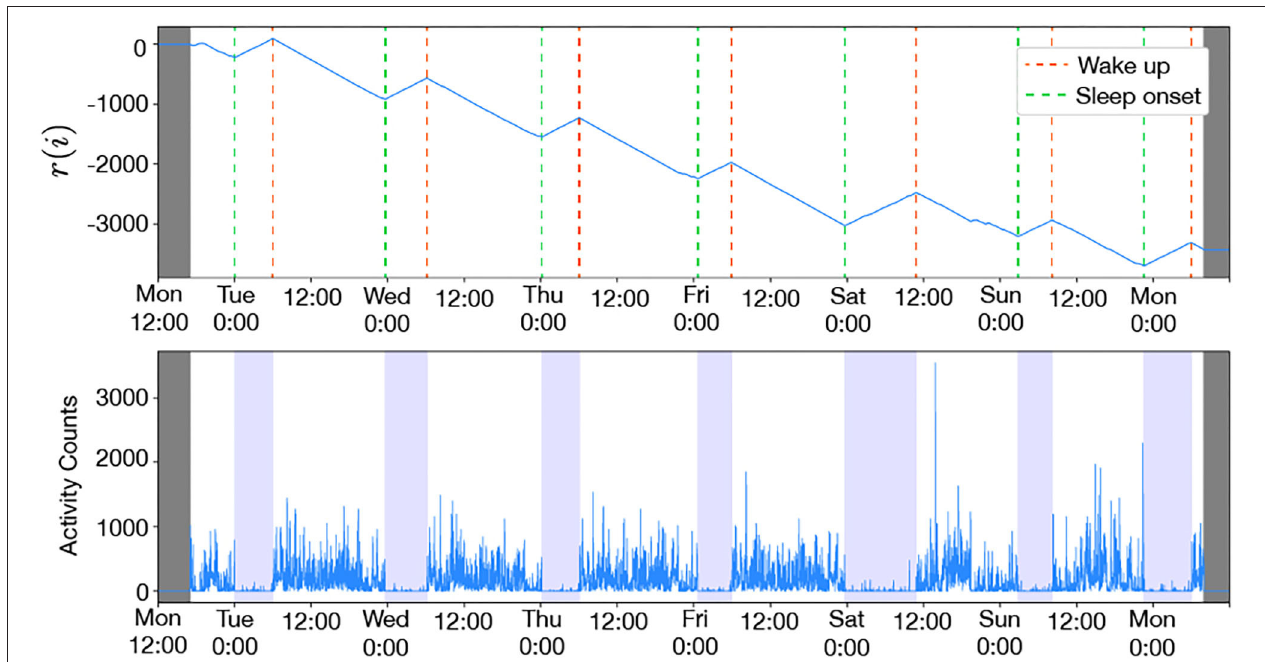
FIGURE 2 | Example of wake-up and sleep-onset times estimated by activity-counts (male, 41 years old, MSF = 3:32): the colored bands in the bottom figure denote the duration between the estimated wake-up and sleep-onset. The sleep/wake function r ( i ) decreased during daytime and increased during the night, and the awake and sleep states repeated in the 24-h cycle. Since the awake state is longer than the sleep state, r ( i ) had a downward trend with the up and down periodic cycle.